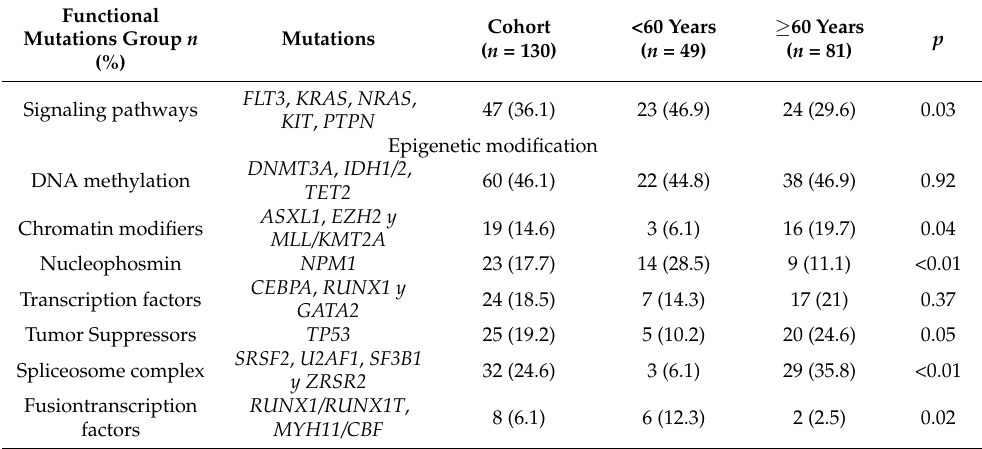
Table 2. Frequencies functional mutations groups in global cohort and grouped by